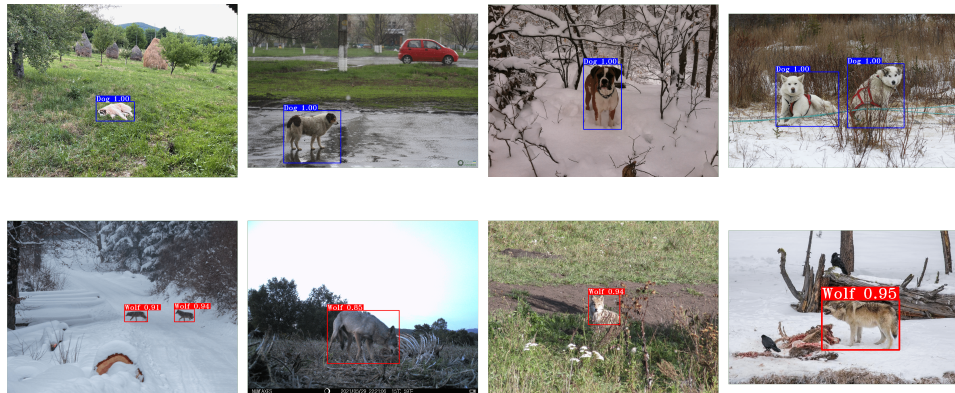
Figure 10. Samples of dogs ( upper row ) and wolves ( bottom row ) in Europe ( left ) and the rest of the world ( right ) with the detections yielded by